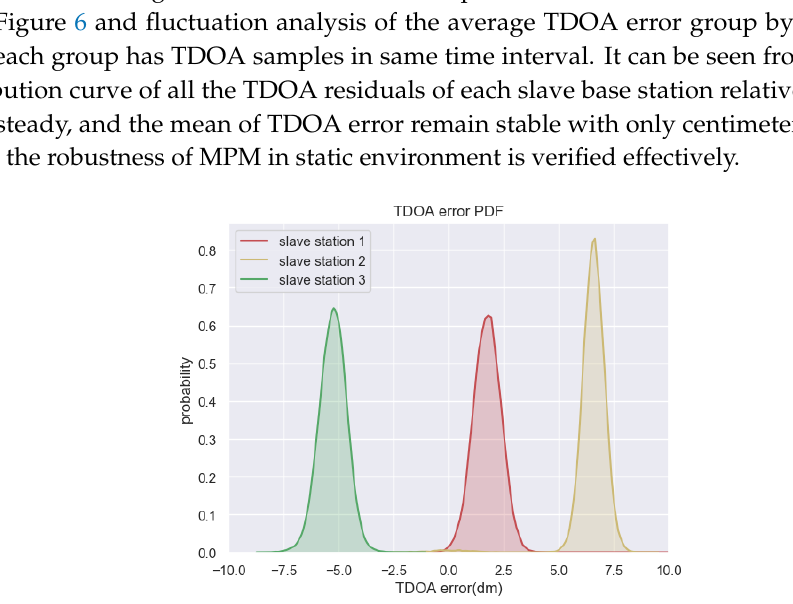
Figure 6. Distribution of time difference of arrival (TDOA) error in non-disturbed environment (In this figure, “dm“ means decimeter).